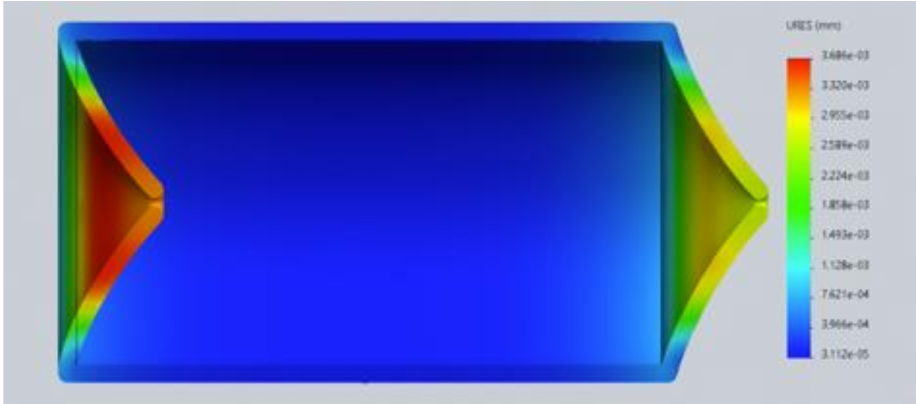
Figure 9. Version 2.0 of the lymphatic vessel: deformation test with open left valve and closed right valve (2020).